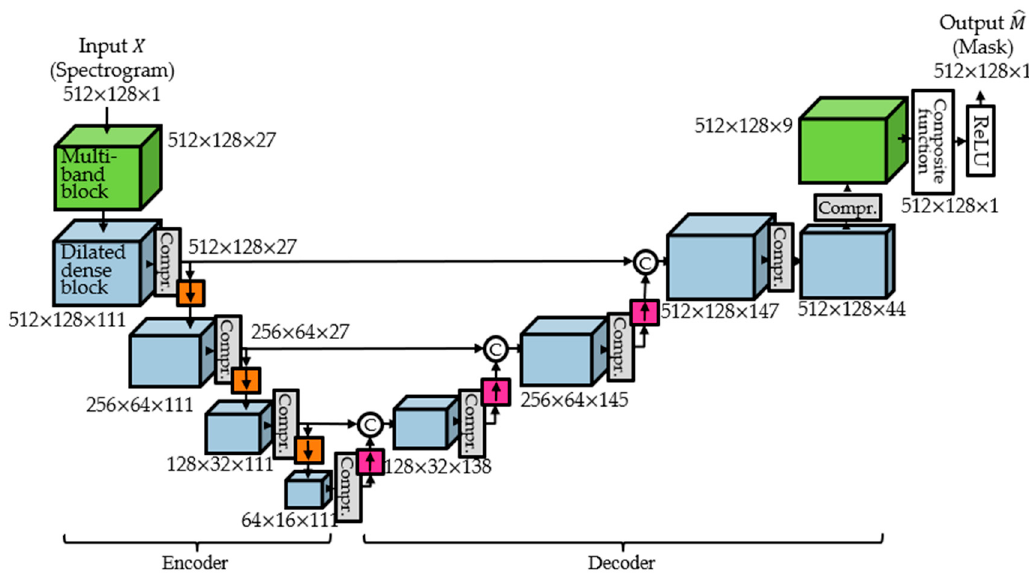
Figure 5. Proposed architecture.